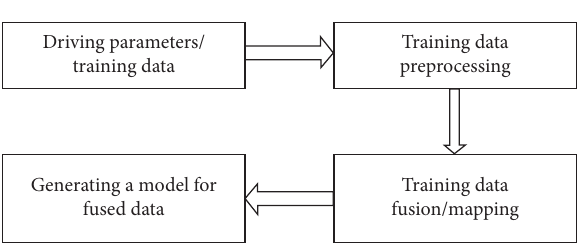
Figure 4: SVM learning